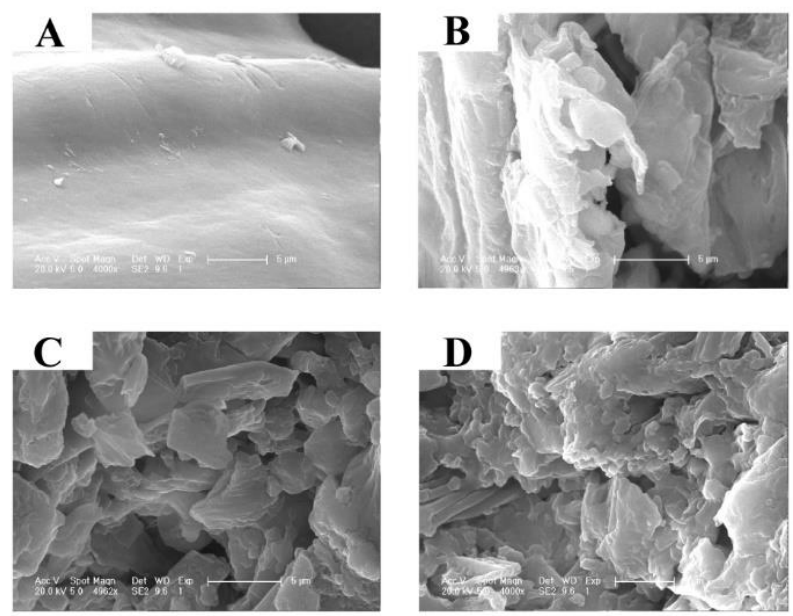
Figure 5. SEM images of the control ( A ), SL ( B ), US ( C ) and PEF ( D ) treated groups.